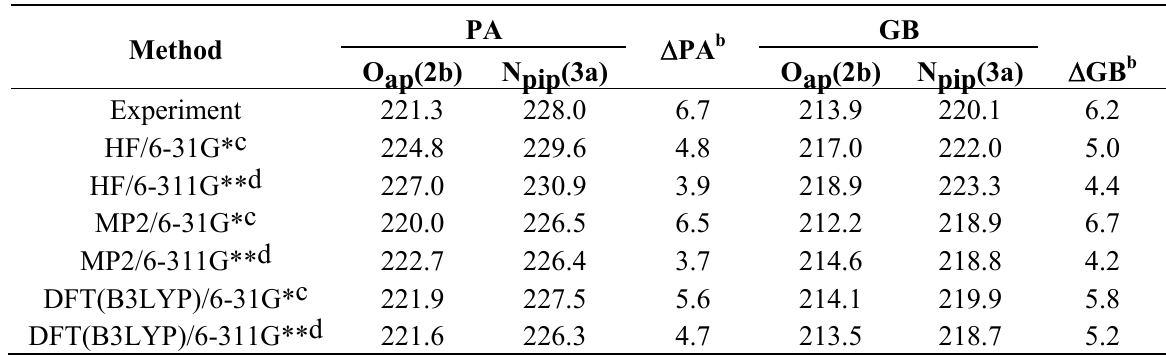
Table 4. Comparison of the experimental [29] proton affinities (PA)a and gas-phase basicities (GB)a of model compounds ( 2 and 3 ) with those calculated for the most basic sites in the most stable isomers of 2b and 3a in the gas phase